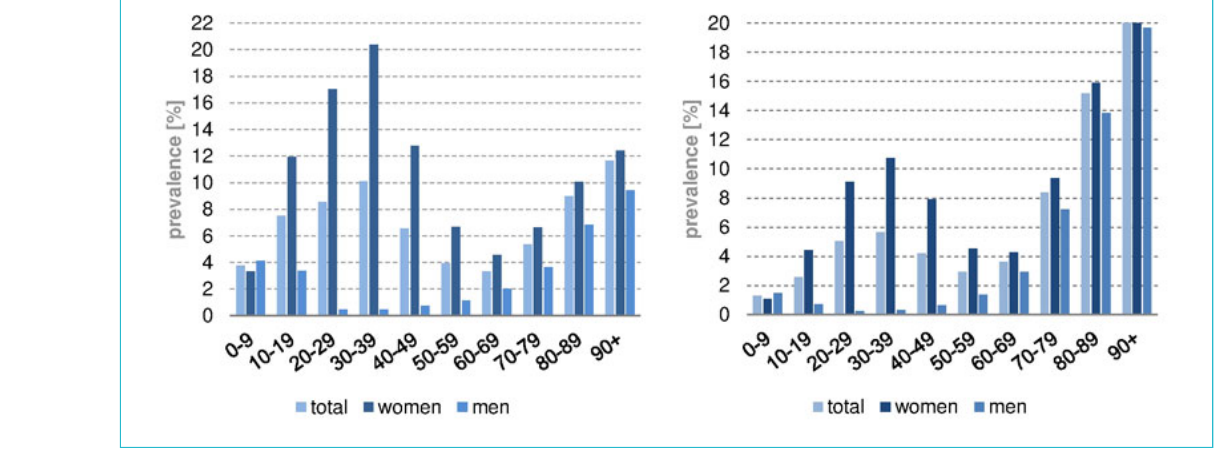
Figure 2: Prevalence of oral iron substitution in different age groups for both sexes in Switzerland (left) and the UK (right), 2012 to